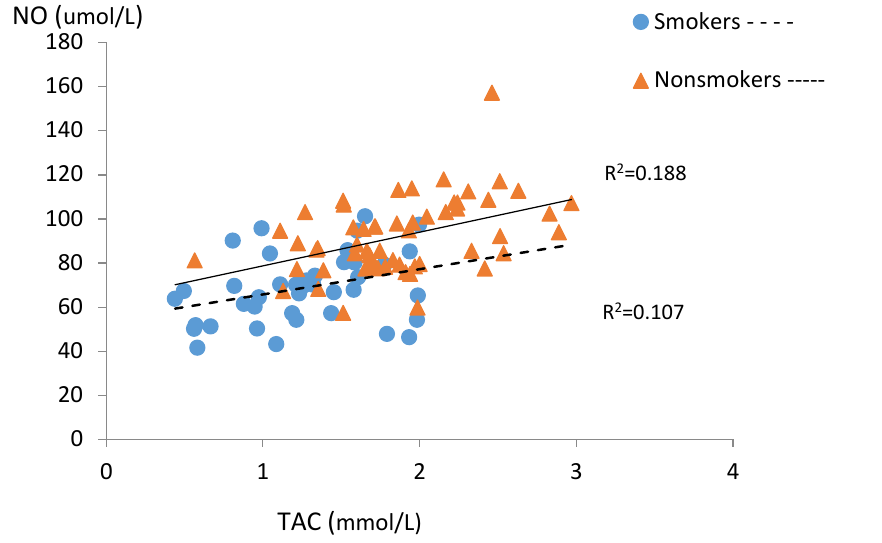
Figure 1. Correlations between serum NO and TAC levels in the subgroups of smoking (n = 42) and non-smoking pregnant women (n = 57).